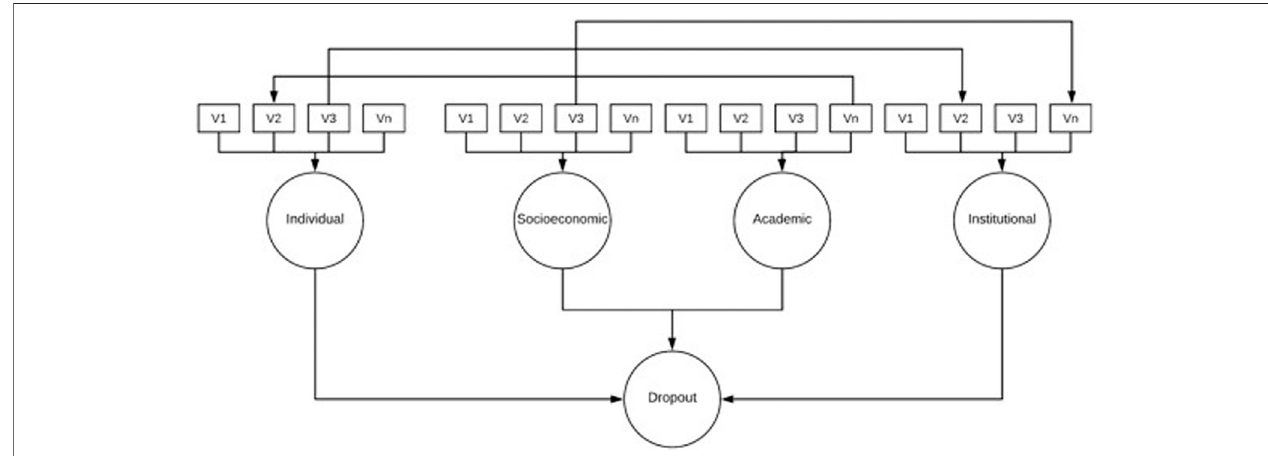
FIGURE 1 | Conceptual model of determinants of dropout. Note: Each determinant groups n variables v1, v2,...,vn as exempli fi ed in the individual determinant. A variable can have an impact on other variables in the same or a different